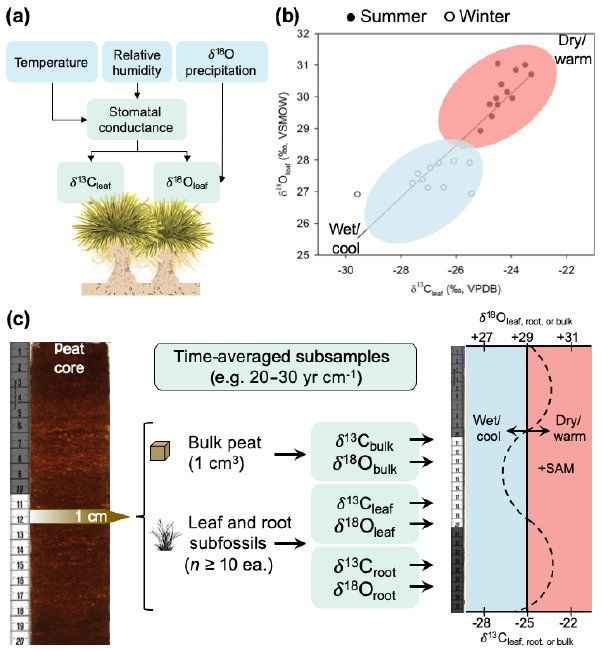
Figure 8. (a) Conceptual model of how climate variation influences biomass δ 13 C and δ 18 O values in P. flabellata through effects on stomatal conductance and δ 18 O of precipitation. (b) Seasonal shifts in leaf δ 13 C and δ 18 O, with open circles representing winter (cool and wet conditions) and closed circles representing summer (warm and dry conditions). (c) Diagram of a proposed paleoclimate re- construction workflow and interpretation of time-averaged (interan- nual) measurements of δ 13 C and δ 18 O in peat